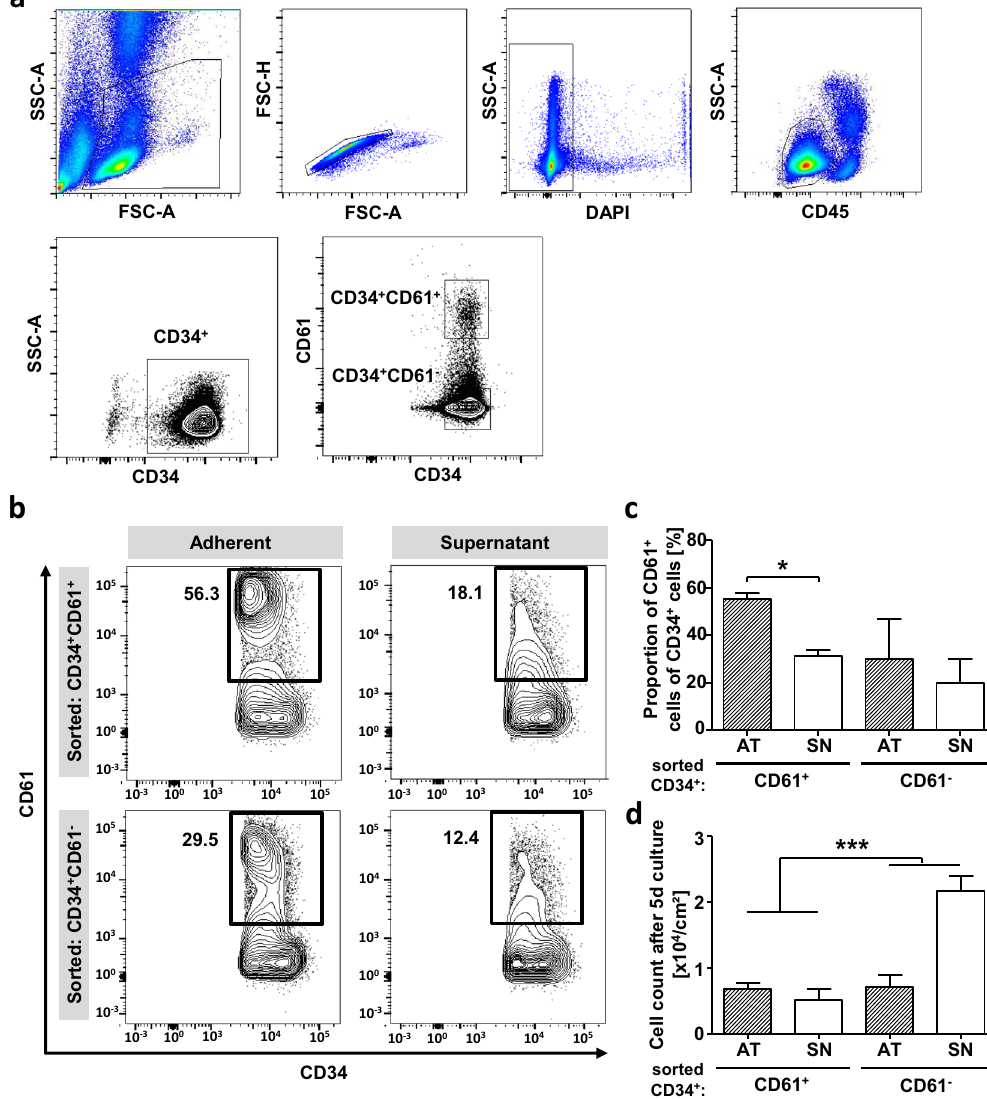
Figure 6. ECM scaffolds induce CD61 surface expression on HSPCs. ( a ) Representative gating strategy for fluorescence activated cell sorting experiments. Lymphocytes and single cells were enriched using light- scatter. Dead cell exclusion was done by DAPI staining. Progenitor enrichment was done using SSC-Alow/ CD45dim and CD34 + gate. Sorting gates CD34 + CD61 - and CD34 + CD61 + . ( b ) Representative FACS plots of CD34 + CD61 + and CD34 + CD61 - sorted fresh cells after 5 days in ECM culture. AT- and SN-cells are shown regarding CD34 and CD61 expression using gates according to sort experiments. ( c ) FACS analysis of CD34 + CD61 + and CD34 + CD61 - sorted cells after 5 days in ECM culture to CD61 expression using gates according to sort experiments. n = 2, Error bars, SD.; * p < 0.05, ** p < 0.01, *** p < 0.001. ( d ) Cell count of AT- and SN-cells of CD34 + CD61 + and CD34 + CD61 - sorted fresh cells after 5 days in ECM culture. n = 2, * = significance compared whole CD34 + CD61 + and CD34 + CD61 - pre-sorted population including AT- and SN-cells, two-tailed t-test; Error bars, SD.; * p < 0.05, ** p < 0.01, *** p <